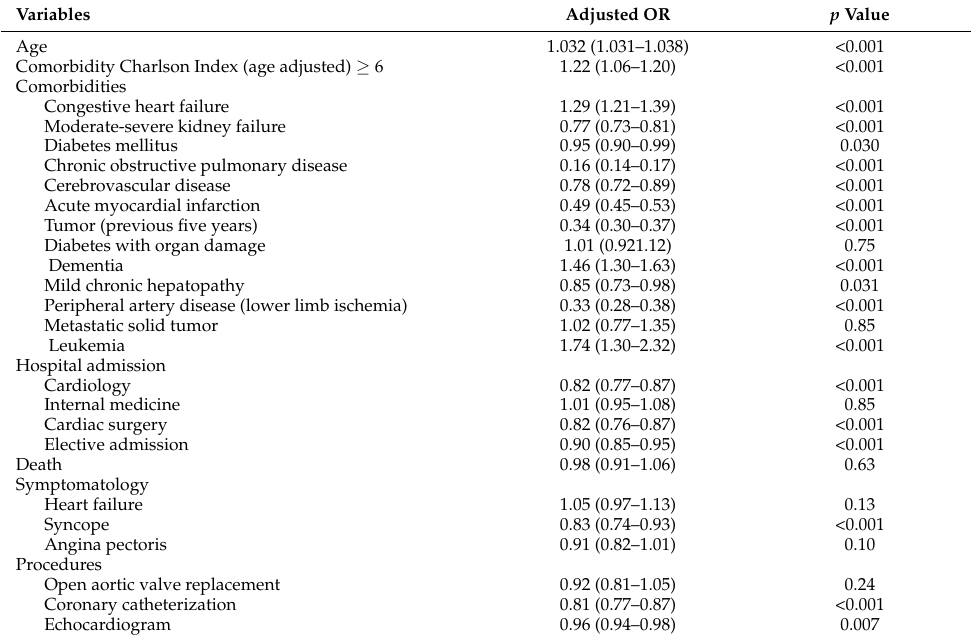
Table 5. Factors associated with aortic stenosis admission in